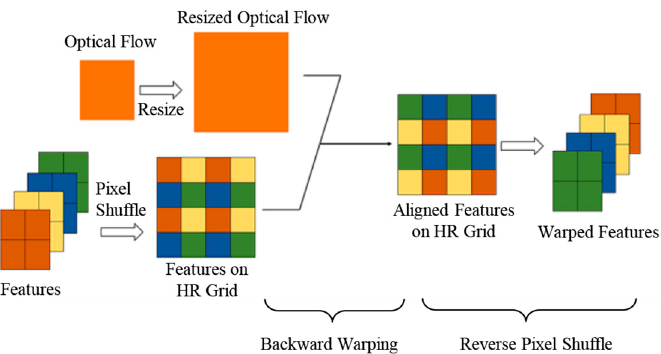
Figure 3. The architecture of the spatial subpixel alignment (SSA) module.